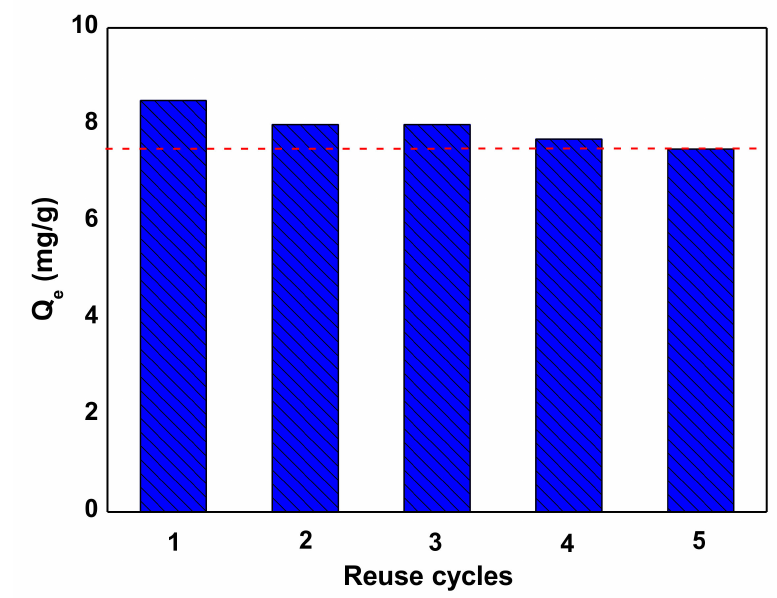
Figure 16. Cycles of reuse (adsorption-desorption) for the system Nd 2 O 3 /